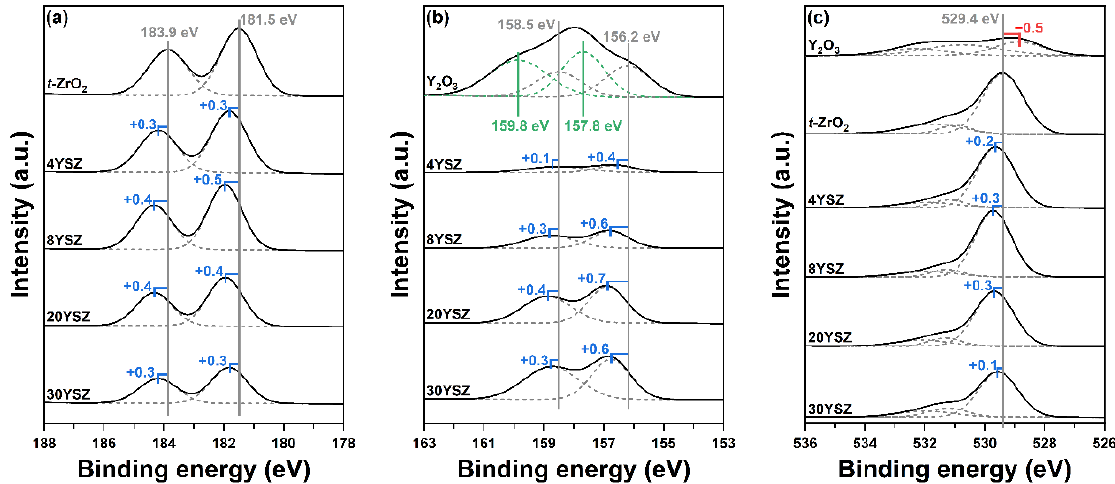
Figure 6. XPS spectra of the co-precipitated YSZ catalysts in the core levels of ( a ) Zr 3d, ( b ) Y 3d, and ( c ) O 1s. The spectra of t -ZrO 2 and/or Y 2 O 3 are added for comparison.